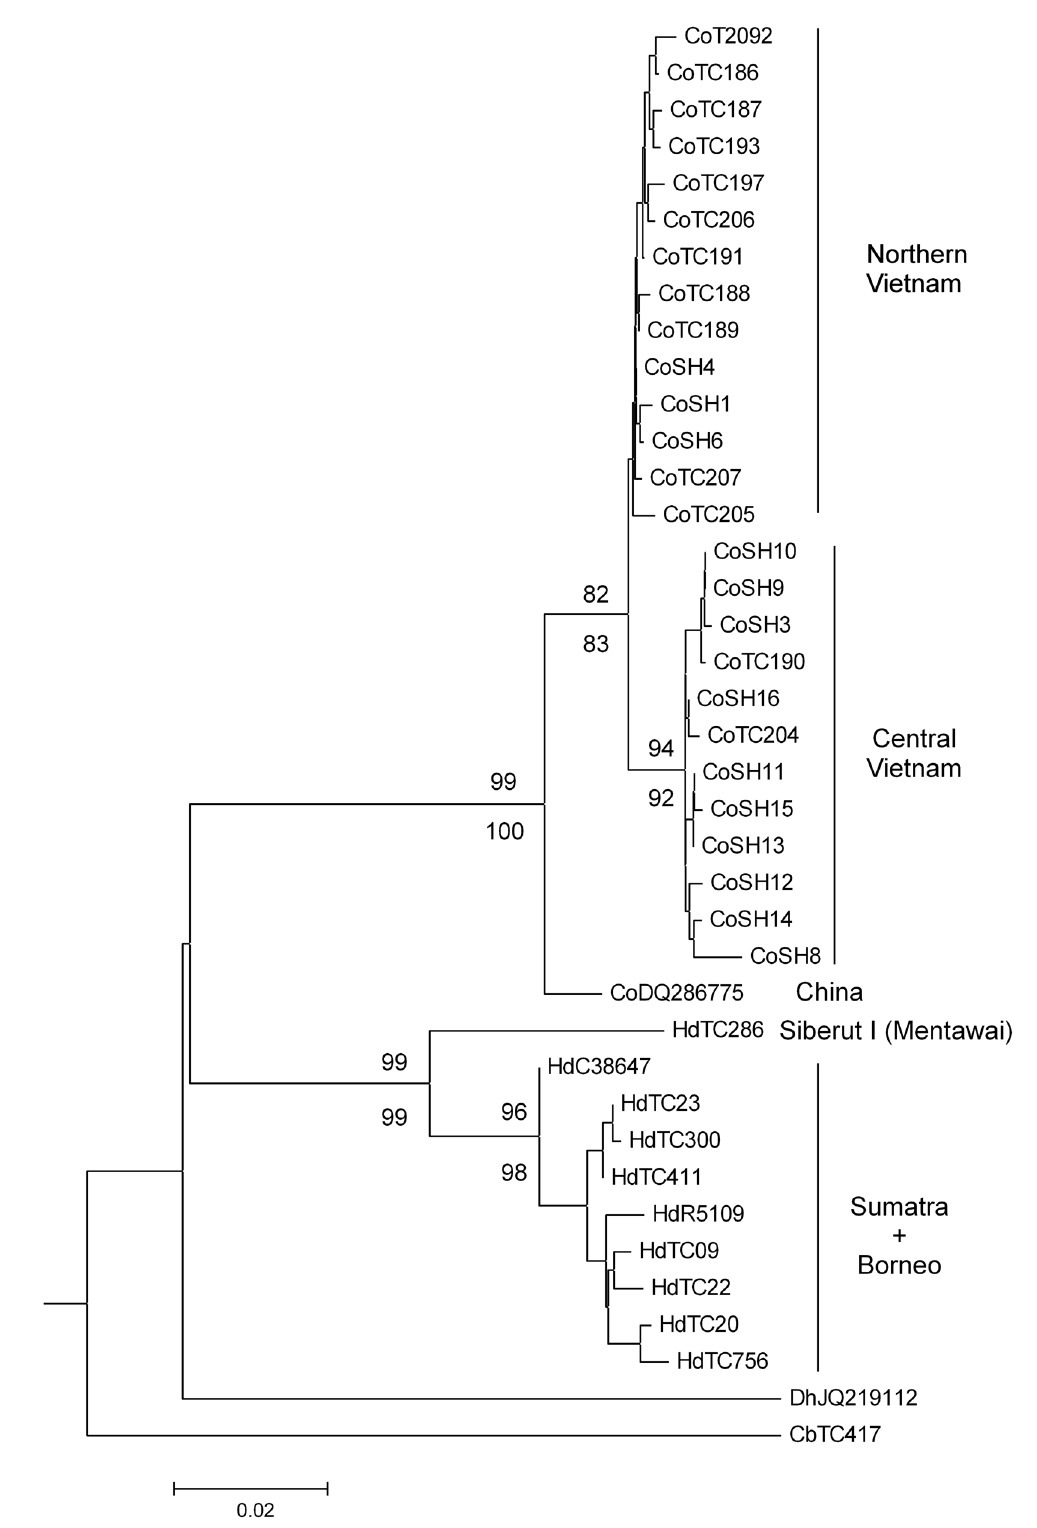
Fig. 3. Phylogenetic tree obtained with NJ for a fragment of Cytb (893 bp). The values over the branches are the bootstrap proportions for NJ, and below the branches are those for ML. Co = Chrotogale owstoni Thomas, 1912; Hd = Hemigalus derbyanus (Gray, 1837); Dh = Diplogale hosei (Thomas, 1892); Cb = Cynogale bennettii Gray,